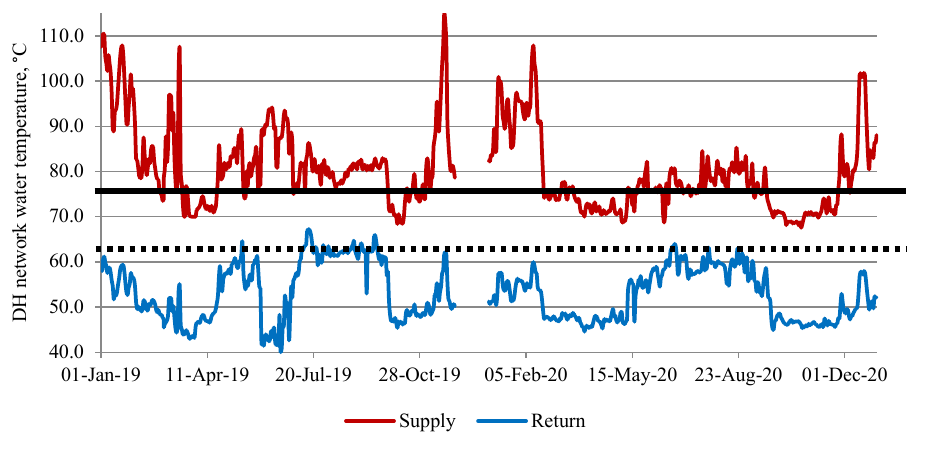
Fig. 1. An effect of weather on supply and return temperatures: they are the highest during cold periods of the year (December and January), although outdoor temperature fluctuations making the whole profile unstable are clearly visible. A black solid line represents value of average supply temperature, while the dashed line is return